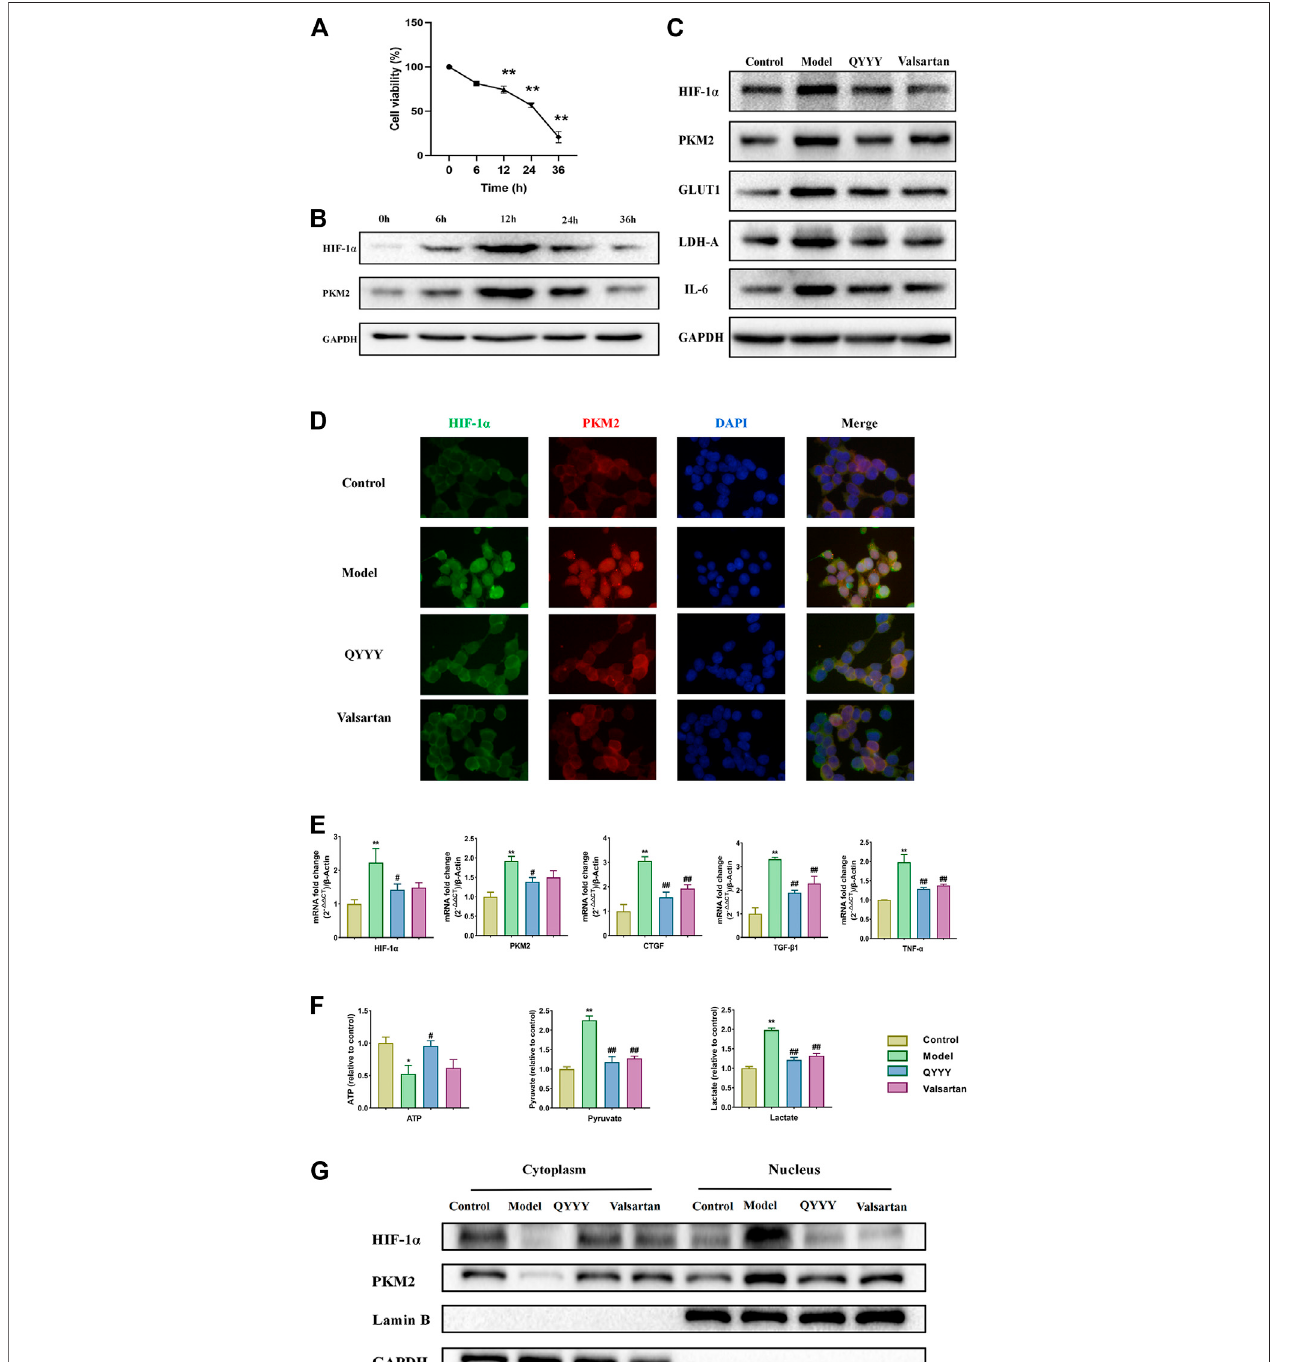
FIGURE 4 | QYYY promoted HIF-1 α , PMK2, metabolic markers, renal in fl ammation and fi brosis in vitro . Cells were divided into following groups: Model group (Hypoxia + 10% blank serum); QYYY group (Hypoxia + 5% QYYY-containing serum + 5% blank serum) and valsartan group (Hypoxia + 10% Valsartan-containing serum).Thecontrolgroupwasmaintainedinahumidi fi edatmosphereof5% CO 2 at37 ° Ctillend ofstudy. (A) Effects ofanoxia time onthe cellviability ofHEK293Twere examined by using MTT. (B) Effects of anoxia time on the protein expression of HIF-1 α and PKM2 of hypoxic HEK293T cells were examined by using western blotting. (C) Effects of QYYY on protein expression of HIF-1 α , PKM2, GLUT1, LDH-A, and IL-6 in hypoxic HEK293T cells were examined by using western blotting. (D) EffectsofQYYYon immuno fl uorescence stainingofHIF-1 α andPKM2 inhypoxicHEK293Tcells. (E) EffectsofQYYYon mRNAlevels ofHIF-1 α ,PKM2, CTGF, TGF- β 1, and TNF- α in hypoxic HEK293T cells were examined by using qPCR. (F) Effects of QYYY on changes of ATP, pyruvate and lactate using kits. (G) Effects of QYYY on nuclear and cytoplasmic protein expression of HIF-1 α and PKM2 in hypoxic HEK293T cells were examined by using western blotting. * p < 0.05 and ** p < 0.01 as compared with the control group. # p < 0.05 and ## p < 0.01 as compared with the model group.